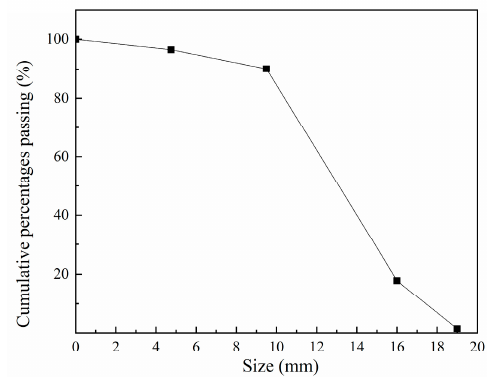
Figure 1. The particle size distribution of coarse aggregate.